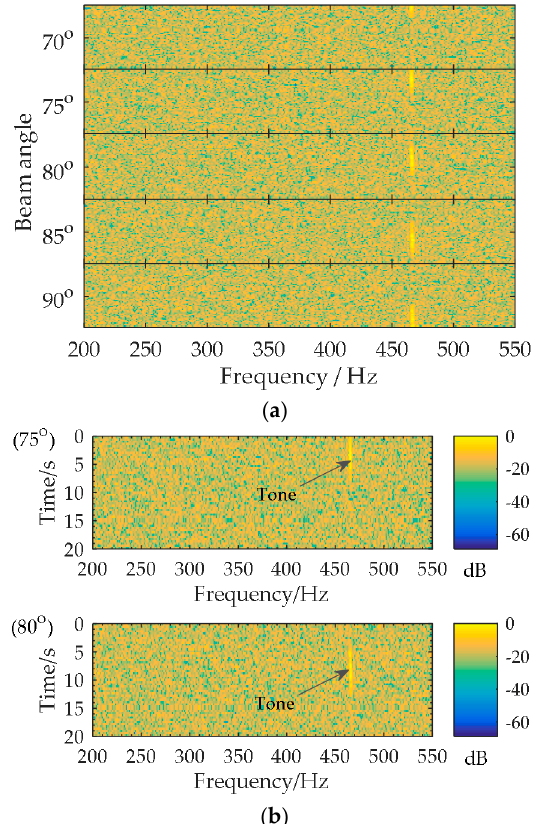
Figure 4. The multi-beam lofargram with a fast variation of target DOA: ( a ) Multi-beam lofargram; Figure 4. The multi ‐ beam lofargram with a fast variation of target DOA: ( a ) Multi ‐ beam lofargram; ( b ) The lofargrams in ( a ) corresponding to the beam angles of 75 ◦ and 80 ◦ ( b ) The lofargrams in ( a ) corresponding to the beam angles of 75° and 80°.